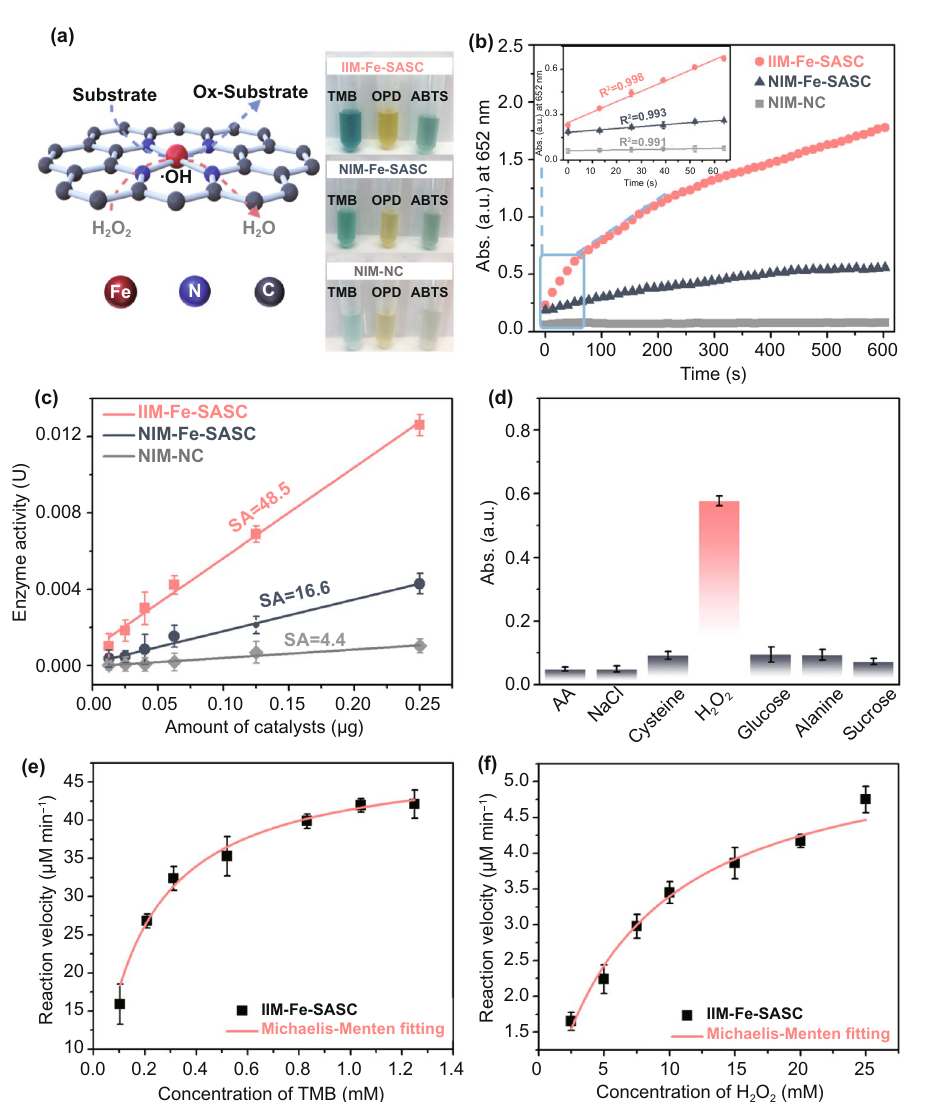
Fig. 3 a Mechanism illustration of IIM-Fe-SASC catalyzed and chromogenic reaction with different substrates. b Absorbance-time curves and magnified initial linear portion of TMB chromogenic reaction catalyzed by IIM-Fe-SASC, NIM-Fe-SASC, and NIM. c Specific activities of IIM-Fe-SASC, NIM-Fe-SASC, and NIM. d Specificity evaluation of IIM-Fe-SASC for various interferences. e–f Steady-state kinetics curves of IIM-Fe-SASC toward TMB and H 2 O